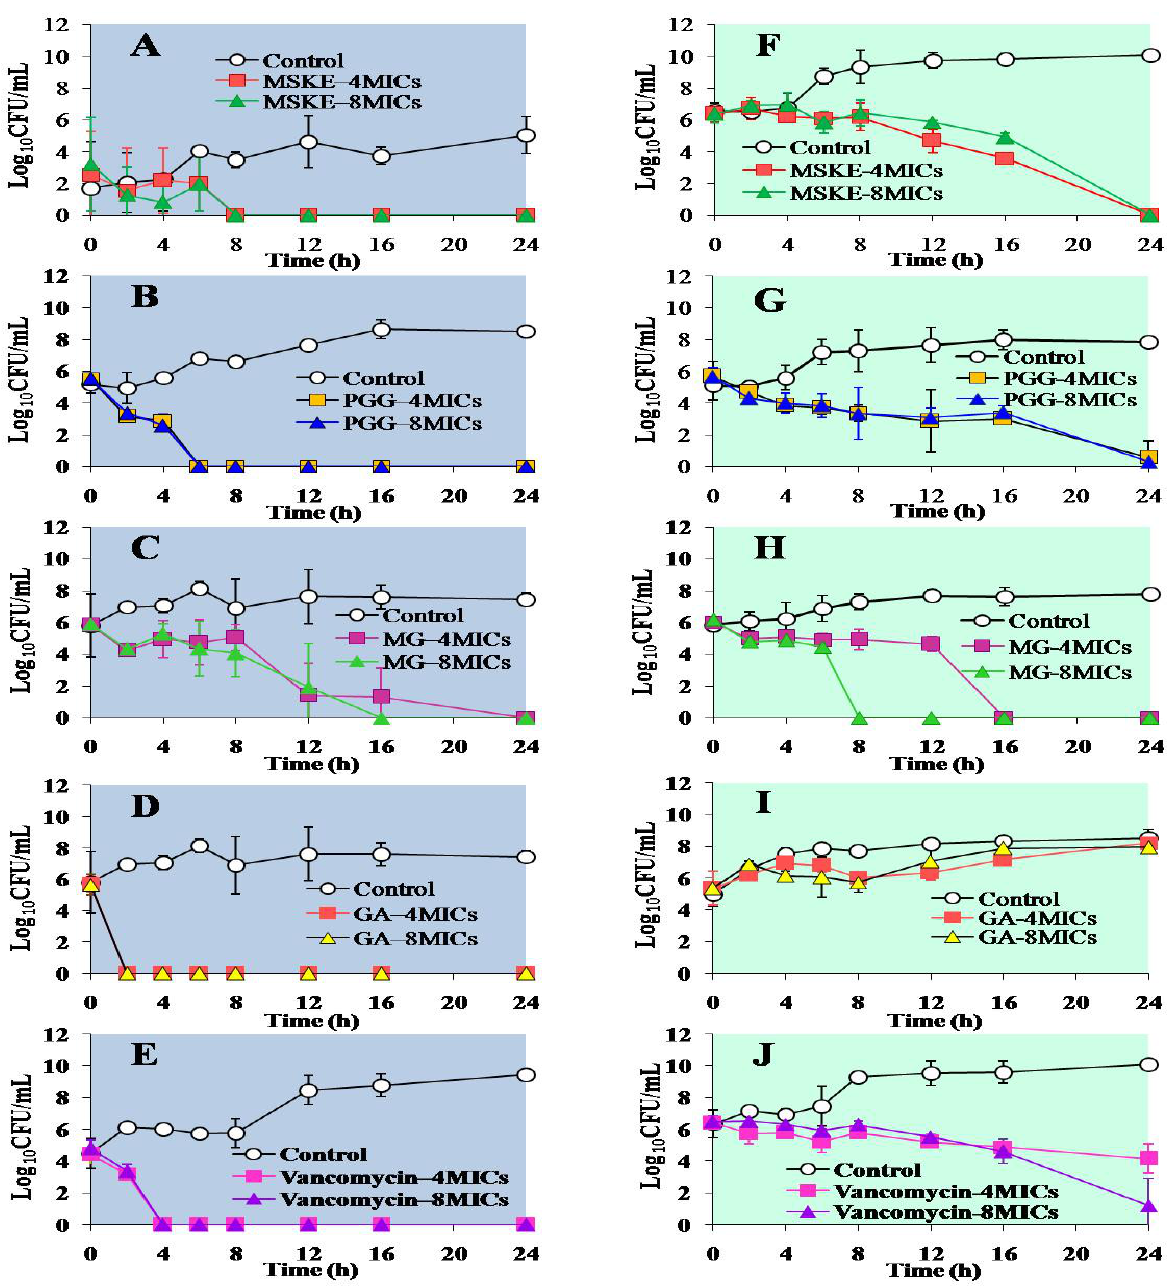
Figure 1. Time–kill curves of S. aureus ATCC 25923 ( A–E ) and the M03 MRSA strain ( F–J ) after treatment with MSKE ( A and F ), PGG ( B and G ), MG ( C and H ), GA ( D and I ) and vancomycin ( E and J ). Each symbol indicates the mean ± S.D. for at least duplicate